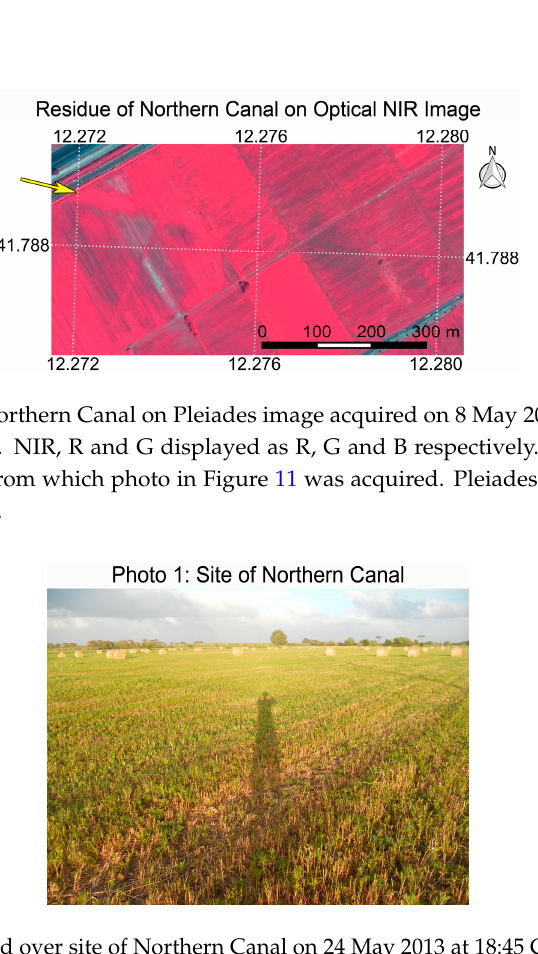
Figure 11. Photo acquired over site of Northern Canal on 24 May 2013 at 18:45 Central European Time (CET). No traces are evident of the Northern Canal. The shadow of the photographer in the center shows the direction of the sun. The location and direction from which the photo was acquired is shown in Figure 10.